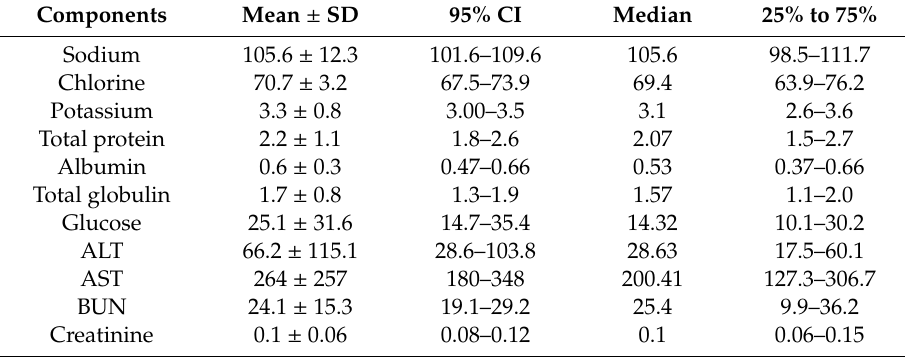
Table 1. The reference intervals of 8 electrolyte components (sodium, chlorine, and potassium) and 8 serum components (total protein, albumin, total globulin, glucose, alanine aminotransferase; ALT, aspartate aminotransferase; AST, blood urea nitrogen; BUN, and creatinine) in 34 wild-caught frogs. We analyzed the mean ± SD, 95% confidence interval (CI), median, and first to third quartile values (25% to 75%) of each